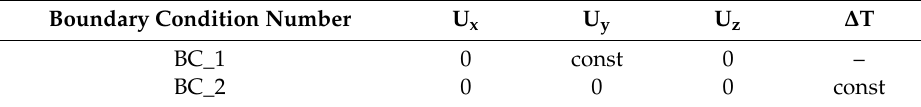
Table 1. The boundary conditions of the internal surface of the